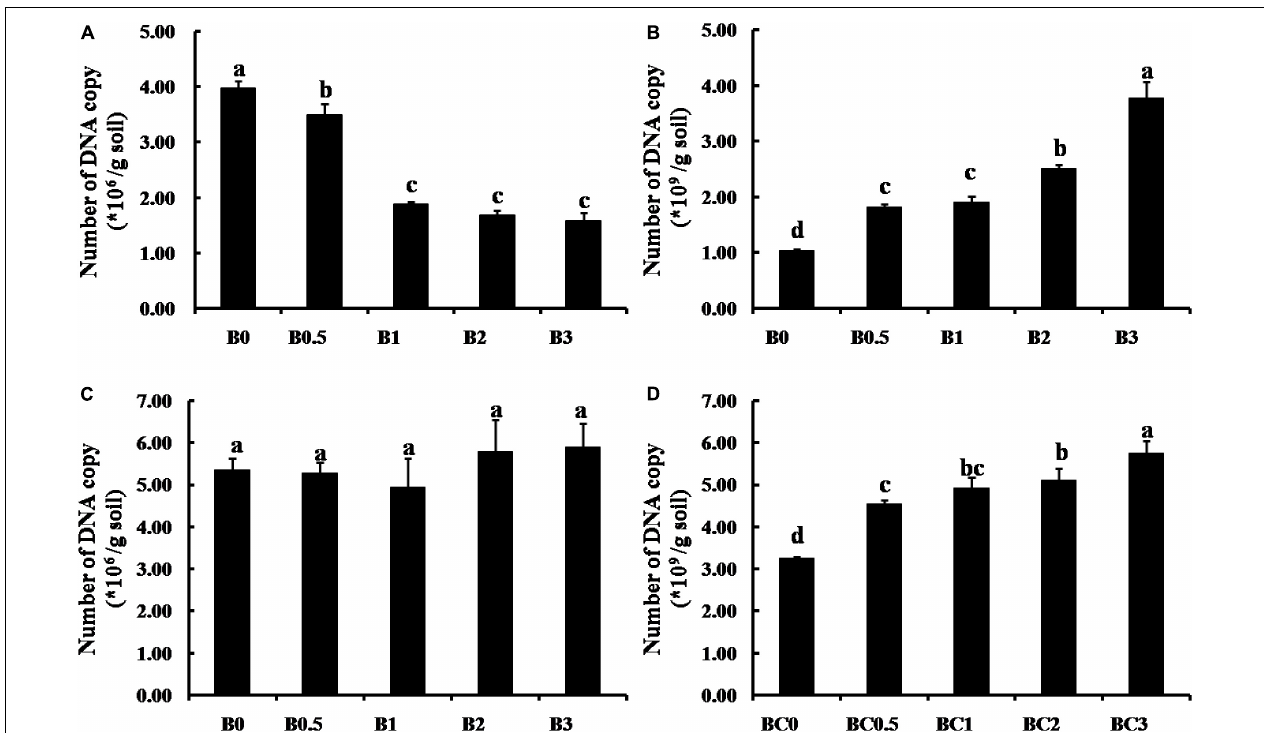
FIGURE 8 | Effect of biochar on pathogen and antagonistic bacteria survival in soil. Panels (A,B) shows the effect of biochar on F. solani and B. subtilis in the natural soil, respectively; (C,D) shows the effect of biochar on F. solani and B. subtilis in the sterilized soil, respectively. B0, B0.5, B1, B2, and B3 represents biochar amendment at a concentration of 0, 0.5, 1, 2, and 3% (w/w), respectively. Error bars indicate the standard error, and the different letters above the bars showed significant differences ( p < 0.05; n =